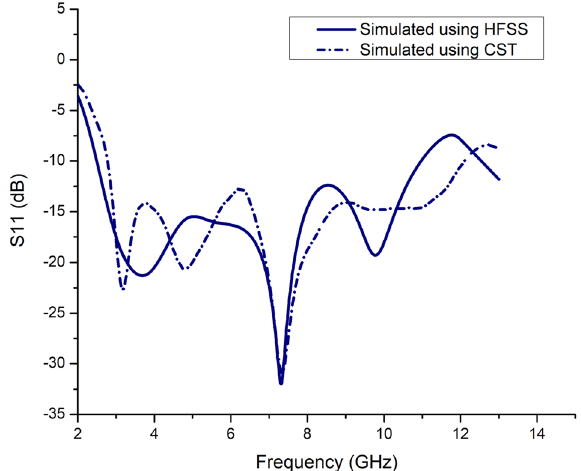
Fig. 3 Simulation result of proposed antenna in HFSS and CST